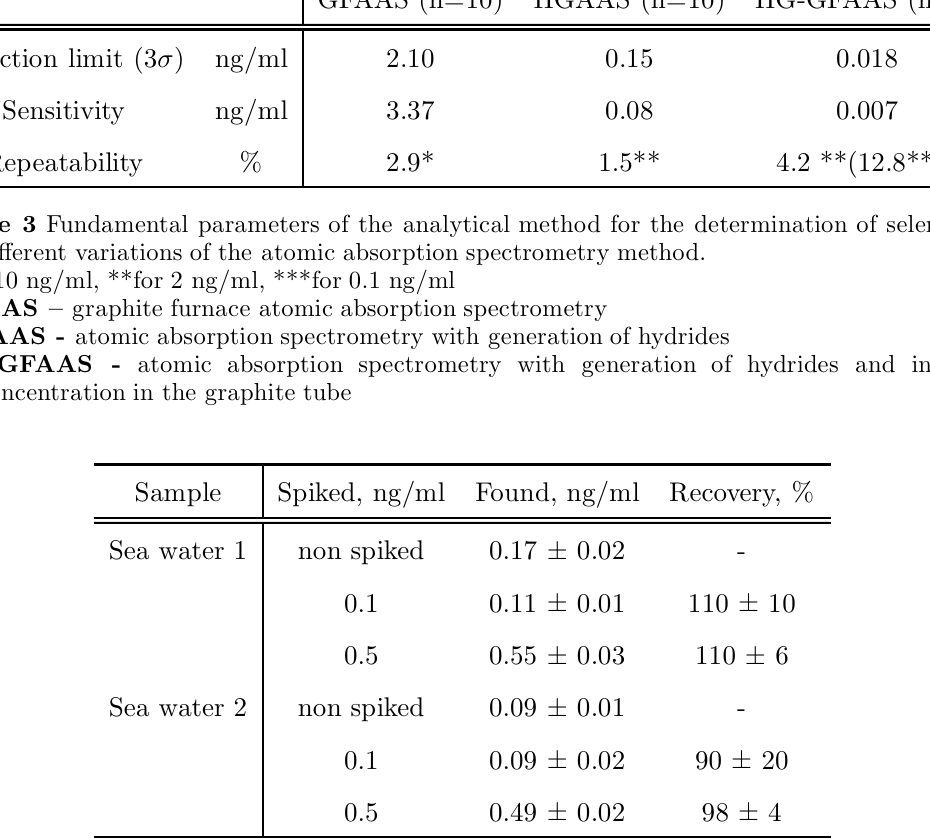
Table 4 Recovery of selenium using the standard addition method and by hydride generation and in-situ pre-concentration in graphite tube